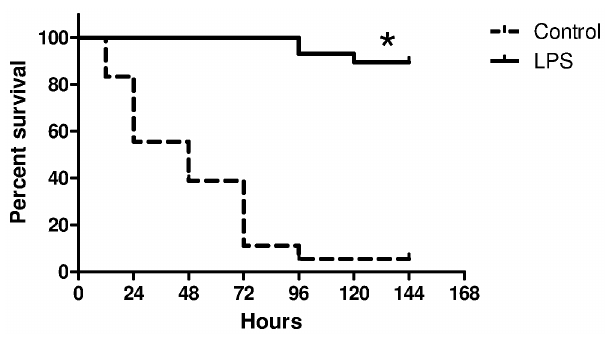
Figure 1. Survival curves for control (N=18) and LPS pretreat- ed mice (N=29) following intravenous bacterial challenge with 2 6 10 6 CFU of S.pneumoniae culture, *log-rank test, p ,